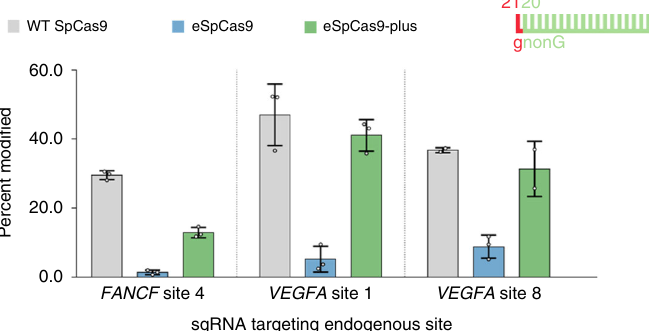
Fig. 7 Blackjack variants facilitate modi fi cation of the endogenous Sprn gene at the 5 ′ coding region and are effective with sgRNAs expressed from a single-copy lentivirus. a Pre-screening targets with increased fi delity nucleases for ef fi ciency by the integration of a donor EGFP cassette. b Based on a the SpCas9-plus variants were selected to generate transgenic lines using the ‘ self-cleaving ’ EGFP-expression plasmid, which must integrate in-frame for Sprn promoter driven EGFP expression, and which downstream from the EGFP coding sequence it also contains a CMV-mCherry cassette; mCherry positive cells were counted. c Indel formation activity of eSpCas9-plus compared to WT and eSpCas9 with 21G-sgRNAs transcribed from an integrated single copy of lentiviruses measured by TIDE. a – c Means are shown, error bars represent the standard deviation (s.d.) for n = 3 biologically independent samples (overlaid as white circles). In the case of VEGFA site 8 targeted with WT and eSpCas9-plus on c one sample point is missing due to sample loss. Spacers are schematically depicted beside the charts as combs: green color teeth indicate matching-, while a red color tooth indicates the presence of an appended nucleotide within the spacer; numbering of tooth position corresponds to the distance of the nucleotide from the PAM; the starting 20th nucleotide of the spacer is indicated by an uppercase letter and an appended 21st nucleotide by a red lowercase non-Blackjack nucleases: eSpCas9-plus, SpCas9-HF1-plus, and B- SpCas9 are superior variants of eSpCas9, SpCas-HF1, and WT SpCas9, respectively. The Blackjack (WT) SpCas9 provides higher fi delity editing than the WT without any detectable decrease in its